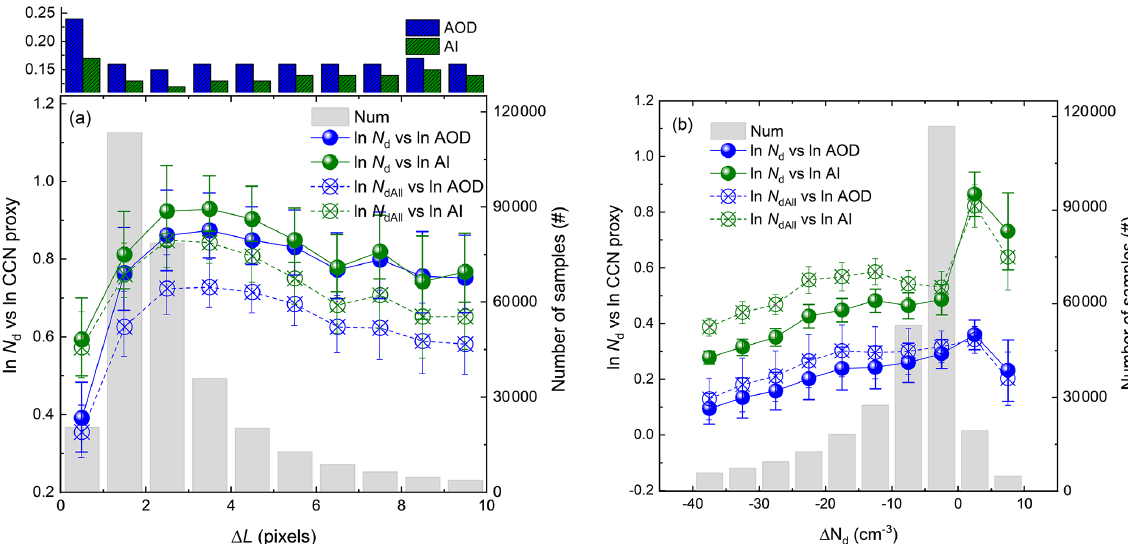
Figure 5. Dependence of the linear regression slopes of ln N d (ln N dAll ) versus ln AOD (ln AI) on (a) (cid:49)L and (b) (cid:49)N d derived via the pre- binned approach. Data are grouped into 10 fixed (cid:49)L ( (cid:49)N d ) intervals for the calculation of slopes. Error bars indicate the 95% confidence interval of the linear regression, and the gray bars denote the total number of samples for each bin. The change in AOD (AI) with (cid:49)L is also shown in the panel (a) . The equivalent figure (Fig. S3) shows similar results based on the all-data